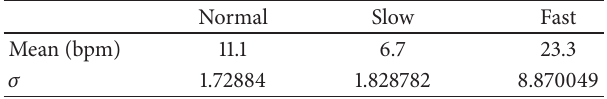
Table 1: Mean and standard deviation ( 𝜎 ) of the breathing rate from all subjects for the requested